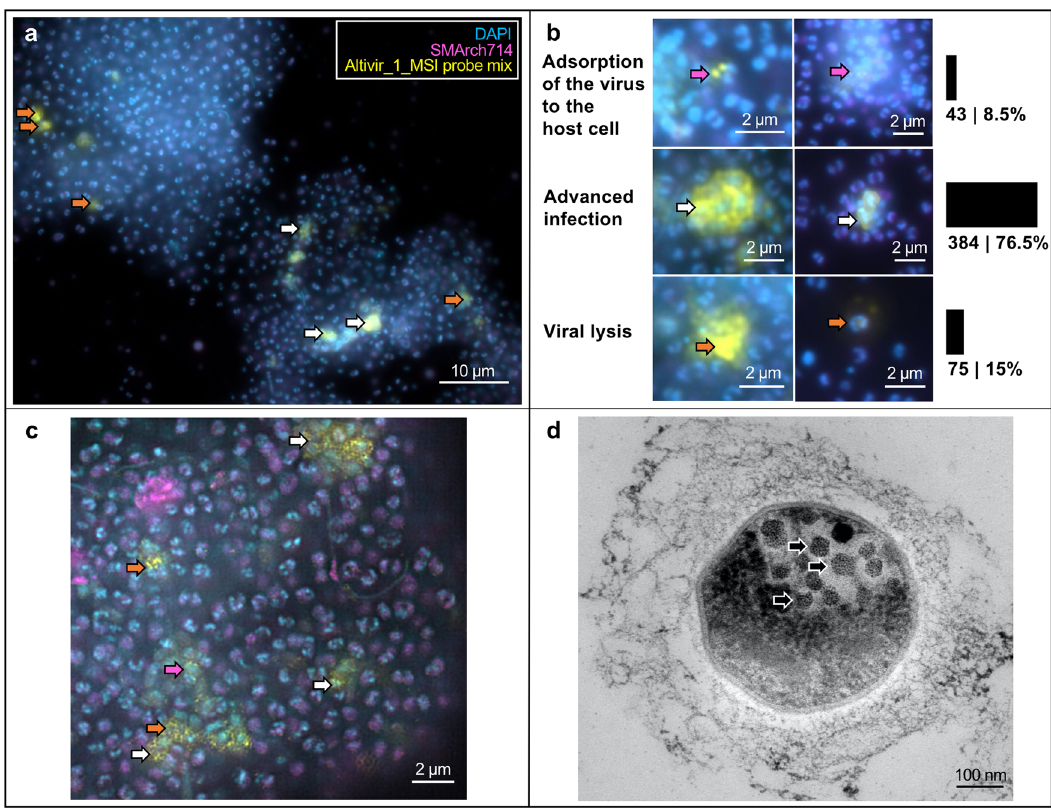
Fig. 3 Visualization and quanti fi cation of Ca. Altiarchaeum virus Altivir_1_MSI-infected and noninfected Altiarchaeota bio fi lm (BF) cells from MSI site. For all virusFISH experiments shown here, an Altivir_1_MSI probe was used for detecting viral infections. BF material was visualized with fi lter sets for DAPI (blue, cells), ATTO 488 (purple, 16S rRNA signal), and Alexa 594 (yellow, viral genomes), and merged for analysis and display purposes. a VirusFISH displays the interactions between Altiarchaeota cells and their virus shown as yellow dots. For unmerged imaging data, see Supplementary Fig. 11. Scale bar: 10 µ m. b Different infection stages with Altivir_1_MSI. The enumeration performed with a regular epi fl uorescence microscope was based on 18,411 archaeal cells and categorized into three infection stages. For the categorization we used in total 18 Altiarchaeota bio fi lms, whereby 17 bio fi lms were treated with the Altivir_1_MSI probe ( n = 17) and one bio fi lm was treated with a Metallosphaera sp. virus probe ( n = 1). Purple arrows indicate exemplary viruses that attach to host ’ s cell surface, white arrows show advanced infections, and orange arrows bursting cells with free viruses. Scale bars: 2 µ m. c Coupling virusFISH with structured illumination microscopy showed extracellular signals of tiny fl uorescently labeled viral particles attaching to Altiarchaeota ’ s cell surface but also in a free state as presumably released virions ( n = 1). Scale bar: 2 µ m. d Transmission electron microscopy revealed intracellular virus-like particles ( n = 3). Scale bar: 100